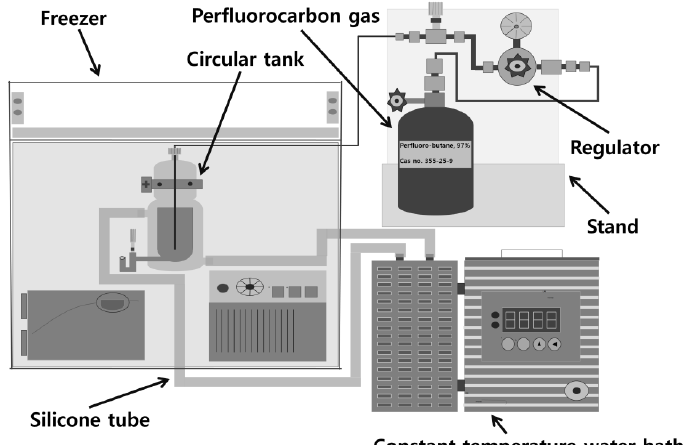
Figure 10. Low temperature workspace and liquefaction of